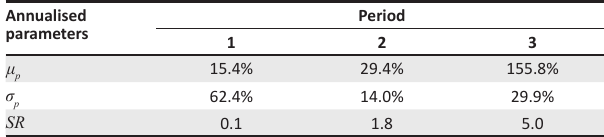
TABLE 2: Summary of portfolio B’s tangent portfolio performance during periods 1, 2 and 3.